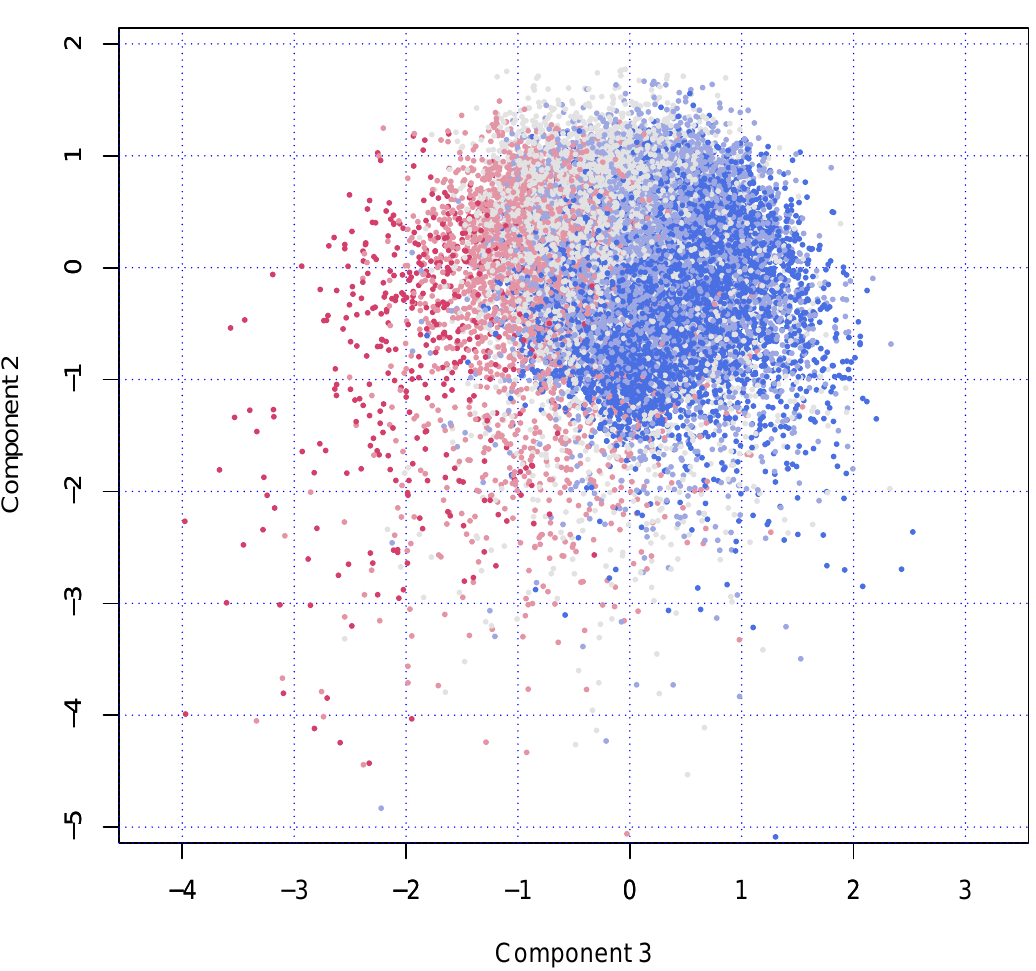
Figure 3. Locations on Components 2 and 3; points are colored according to age group (blue = 50–59 years, red = 80–105 years) (Front